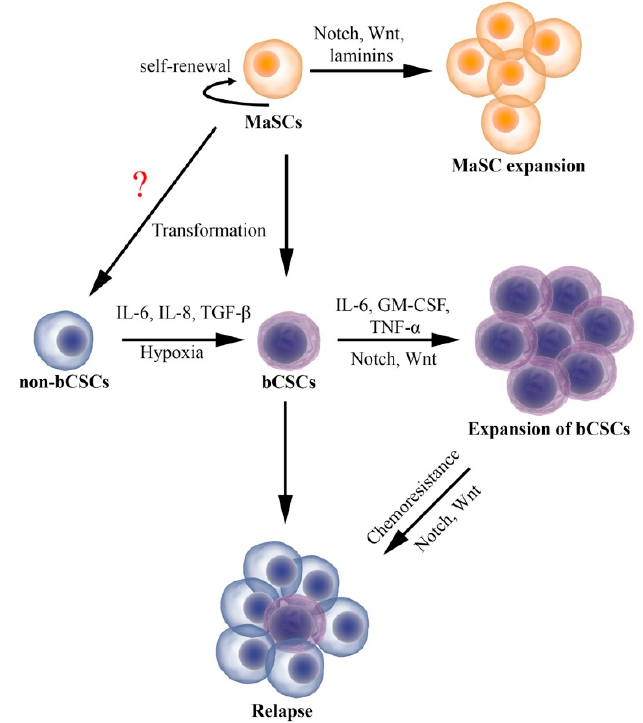
Figure 2. Schematic representation of mammary stem cell (MaSC) expansion, breast cancer stem cell (bCSC) plasticity, development of chemoresistance and relapse. Different cytokines released by immune cells, fibroblasts, adipocytes along with tumor cells in the tumor microenvironment regulate both MaSC and bCSC activity. It is possible that MaSCs could acquire sufficient genetic changes that allow them to transform directly into malignant cancer cells devoid of stem cell properties (non-bCSCs). However, this hypothesis requires further experimental evidence.